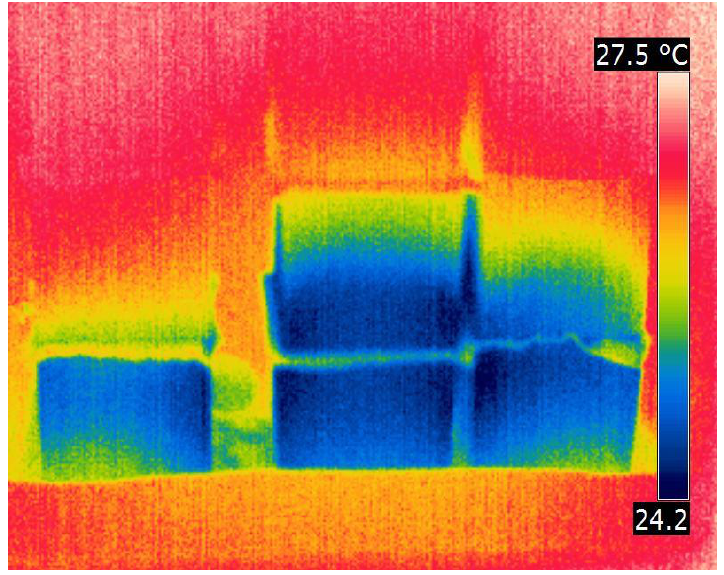
Figure A3. Thermographic report dated October 5, 2018, for Carparo (C.), Lecce stone (L.S.), and Tuff (T.).